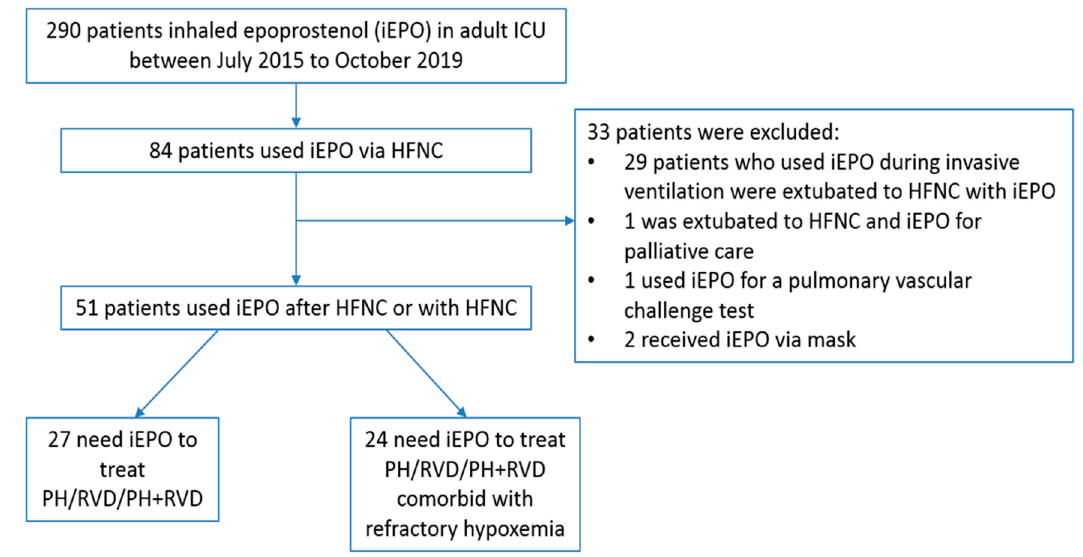
Figure 1. Study flowchart. iEPO, inhaled epoprostenol; HFNC, high-flow nasal cannula; PH, pulmonary hypertension; RVD, right ventricular dysfunction